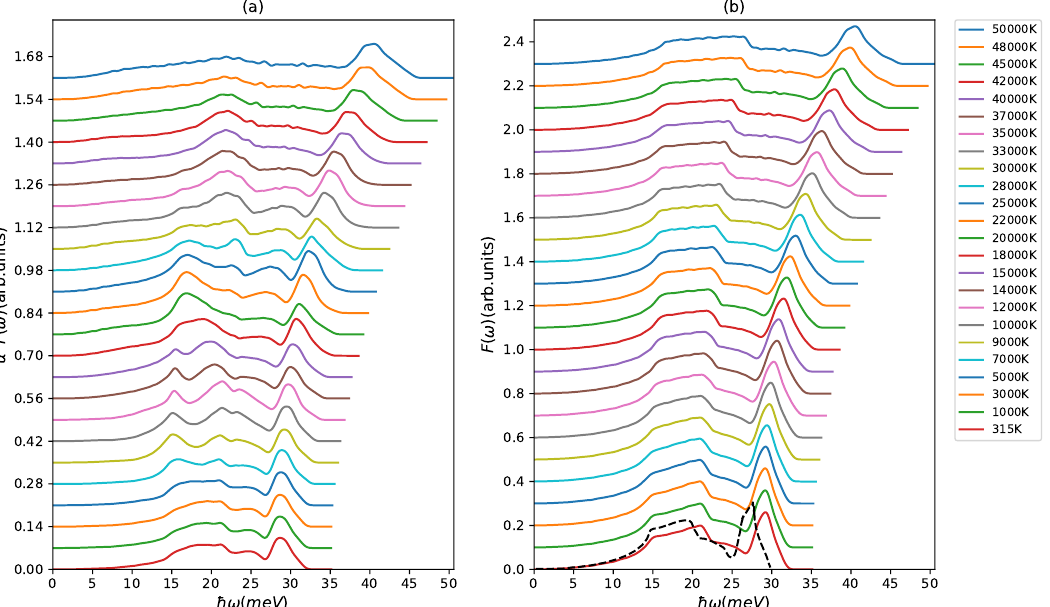
Figure 4. ( a ) Eliashberg function α 2 F ( ω ) and ( b ) phonon density of states F ( ω ) of copper at different electron temperatures (shifted along the y-axis for better visibility). The black dashed line is the result for the phonon-DOS by Ono